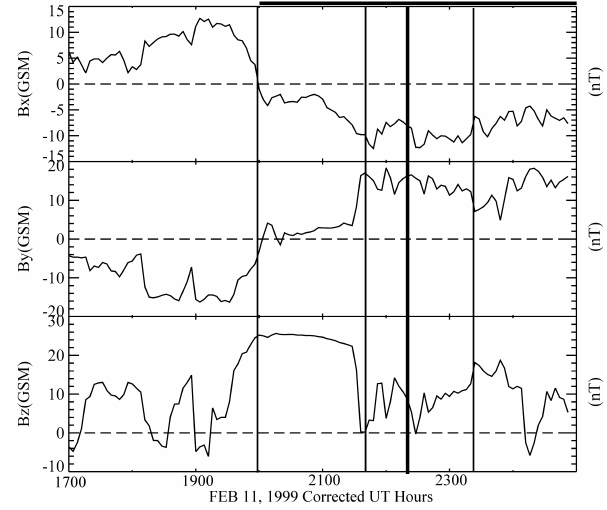
Fig. 11. Shown are magnetic field data from the ACE satellite which orbits the L1 Lagrange point about 200 R E sunward of the Earth. IMF GSM components are plotted for 11 February 1999, as a func- tion of corrected universal time (UT plus the estimated propagation time from the satellite to GSM X =0); about 1h. The thickest ver- tical line marks the time when the TPA is aligned along the noon- midnight meridian. The thick horizontal line at the top denotes the time period when UVI data are